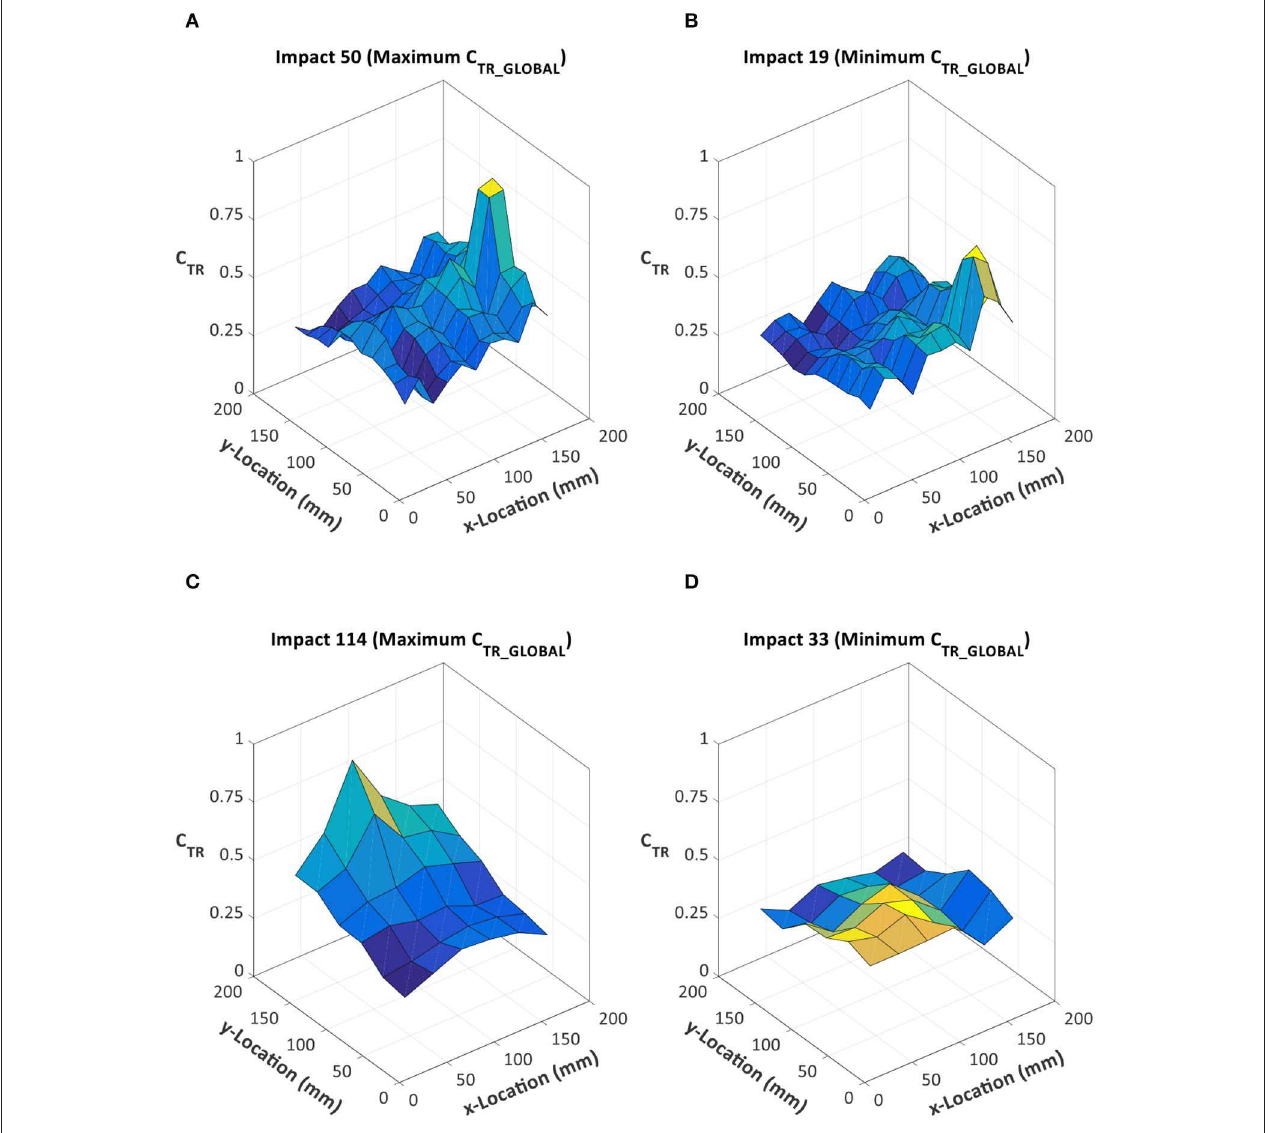
FIGURE 7 | C TR distributions of no grid refinement for impacts associated to the maximum (A) and minimum (B) C TR_GLOBAL values and C TR distributions of grid refinement for impacts associated to the maximum (C) and minimum (D) C TR_GLOBAL .